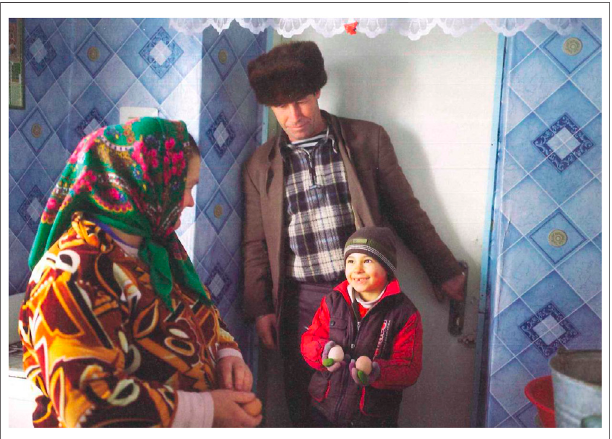
FIGURE 2 | From the series Land ohne Eltern (land without parents). Photo Andrea Diefenbach (2012).